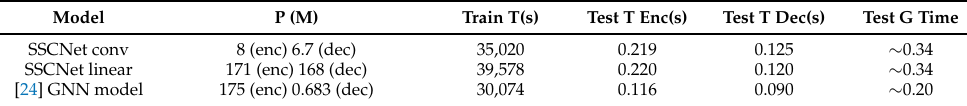
Table 6. Computational time (over VIRTIS-Rosetta dataset) of the SSCNet with the last convolutional layer version (SSCnet conv), the last linear layer version (SSCNet linear), and [24] GNN model. We report the number of parameters for the encoder/decoder networks (P), training time (Train T), test time encoder/decoder, and global test time (Test G time) using 1064 test instances and 128 as batch size (1000 epochs). The test of encoder/decoder time is meant as the average time of each